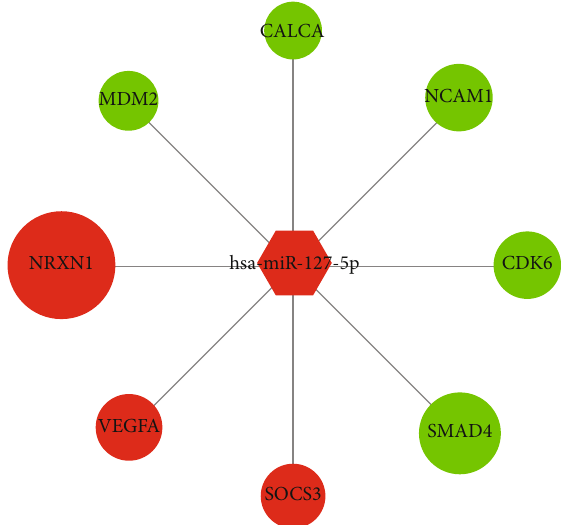
Figure 4: The key miRNA-target interaction regulatory network. (The size of each node was proportional to |log(fold change)| value. The green color indicates downregulation, and the red color indicates upregulation. The circular node represents key mRNA, and the hexagon node represents